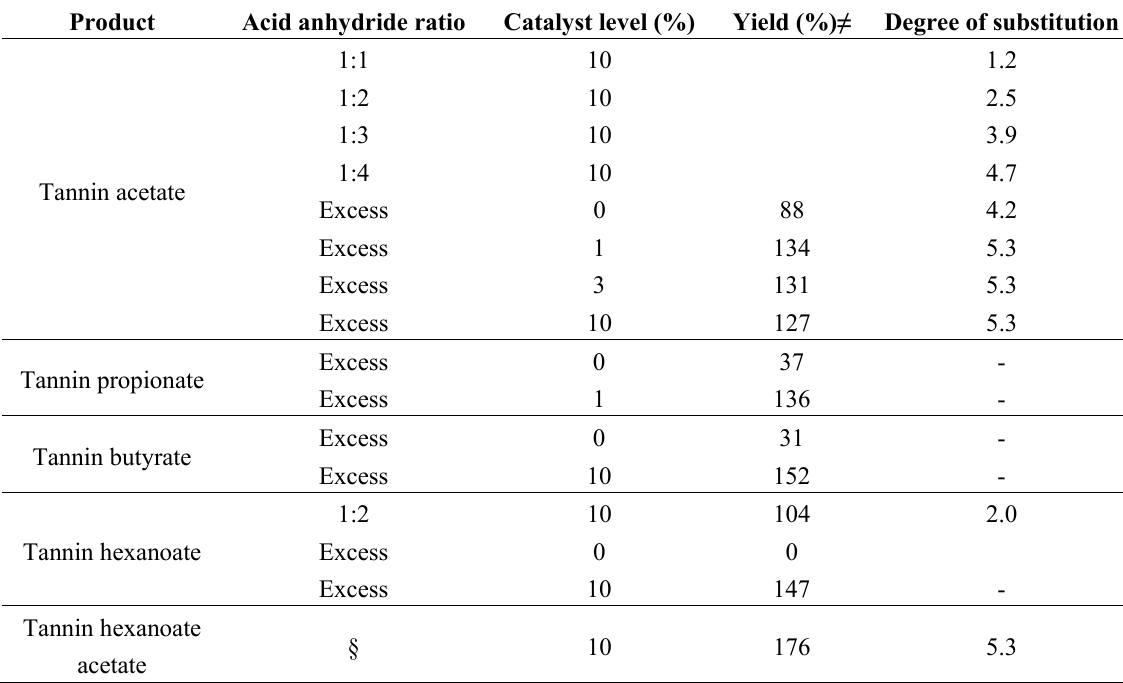
Table 1. Ratios and isolated yields for tannin esterification reactions using acid anhydrides and 1-methylimidiazole as catalyst. The degree of substitution present in tannin ester products is calculated using NMR